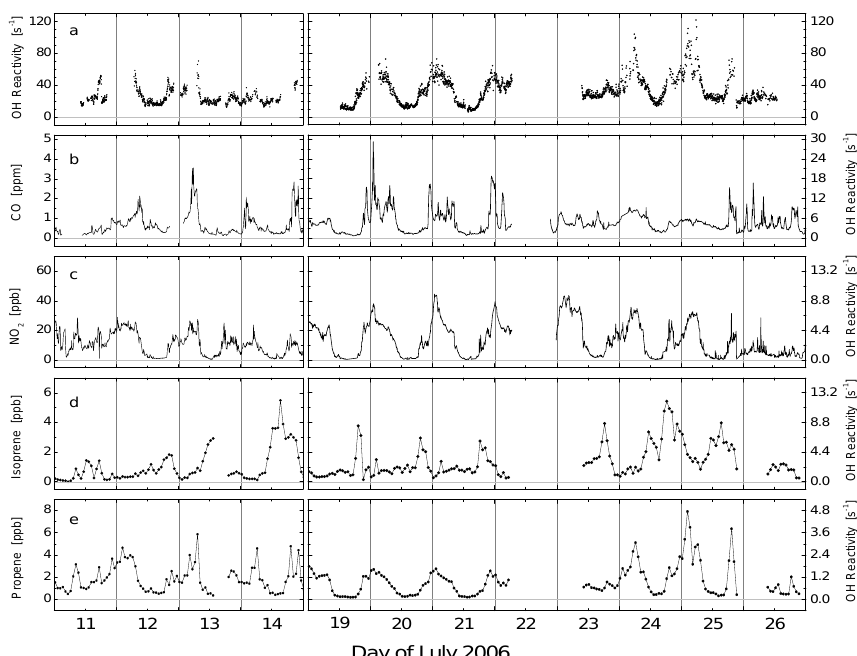
Fig. 3. Total OH reactivity (a) and volume mixing ratios of CO (b) , NO 2 (c) , isoprene (d) and propene (e) measured at Backgarden site in PRD from 11 July to 26 July 2008. The right axis of panels (b)–(e) show corresponding reactivities of the individual trace gases. Data gaps at 15–18 July and 22 July were caused by heavy rain during the typhoon Bilis and an electrical power blackout, respectively. Vertical lines denote